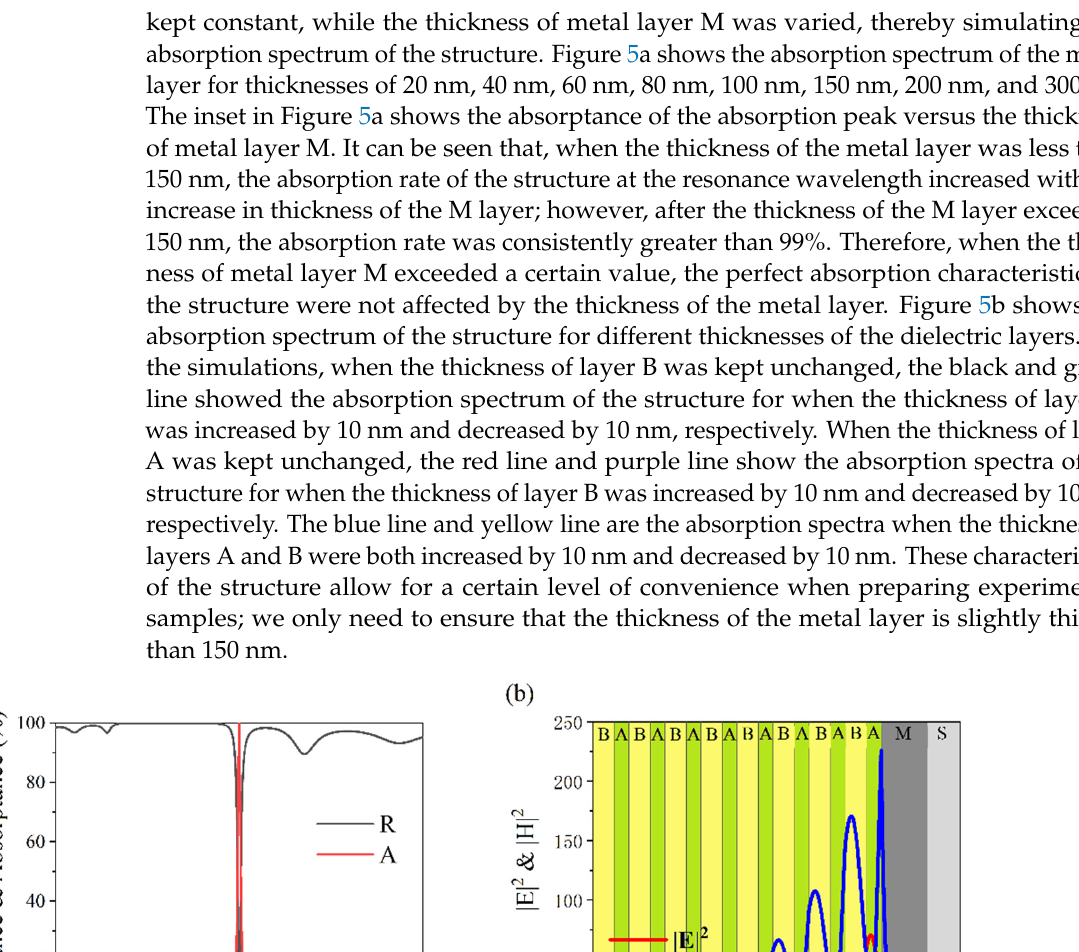
Figure 4. ( a ) Simulated reflection (solid black line) and absorption (solid red line) spectra of (BA) 8 MS. The parameters are: d A = 63.2 nm, d B = 93.8 nm, d M = 200 nm. ( b ) Simulated intensities of |E| 2 (solid red line) and |H| 2 (solid blue line) in (BA) 8 MS at an absorption wavelength of 600 nm.